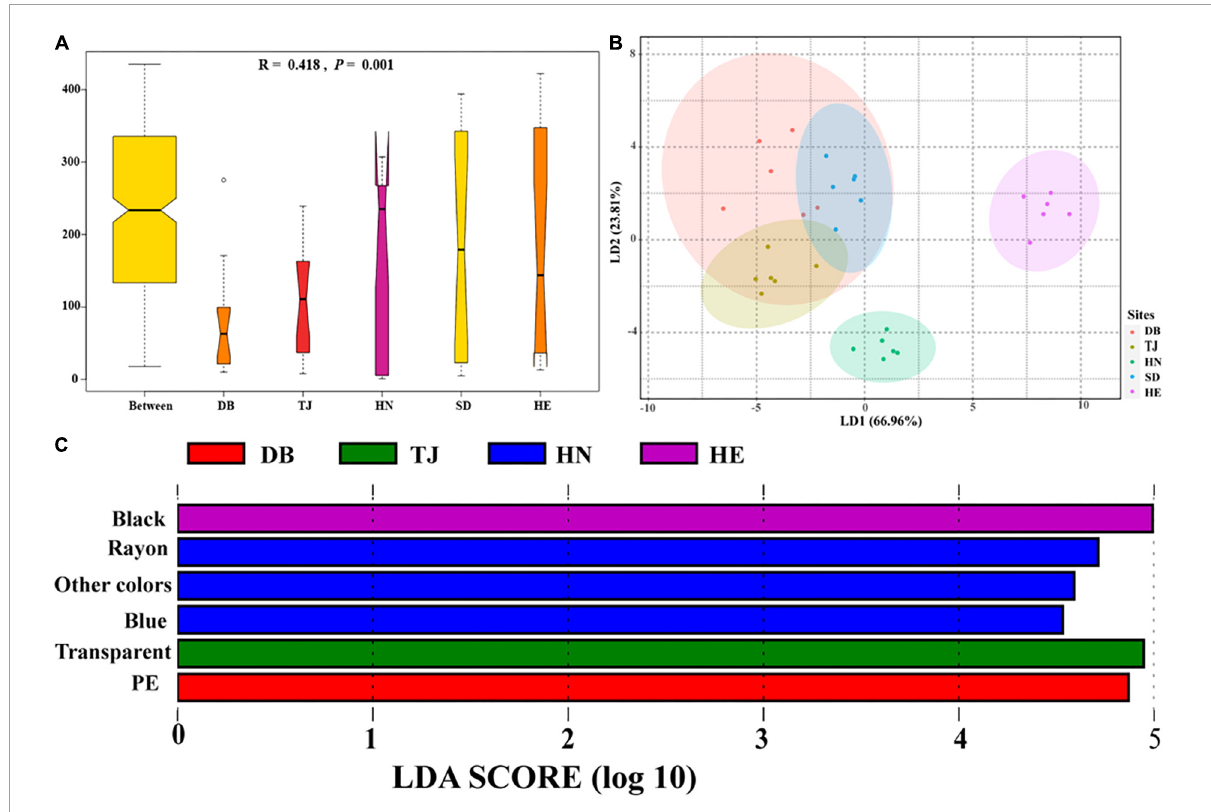
FIGURE5 Differences of microplastic communities based on shape, color, and polymer types in different environments. Analysis of similarities (ANOSIM) was used for variance testing, and y -axis represents the dissimilarity ranks between and within environments, (A) ; Linear discriminant analysis (LDA) was used to maximize the differences of paddy soils among geographic positions, (B) ; LDA Effect Size (LEfSe) was used to identify characteristic microplastic types of paddy soils among geographic positions, (C) .